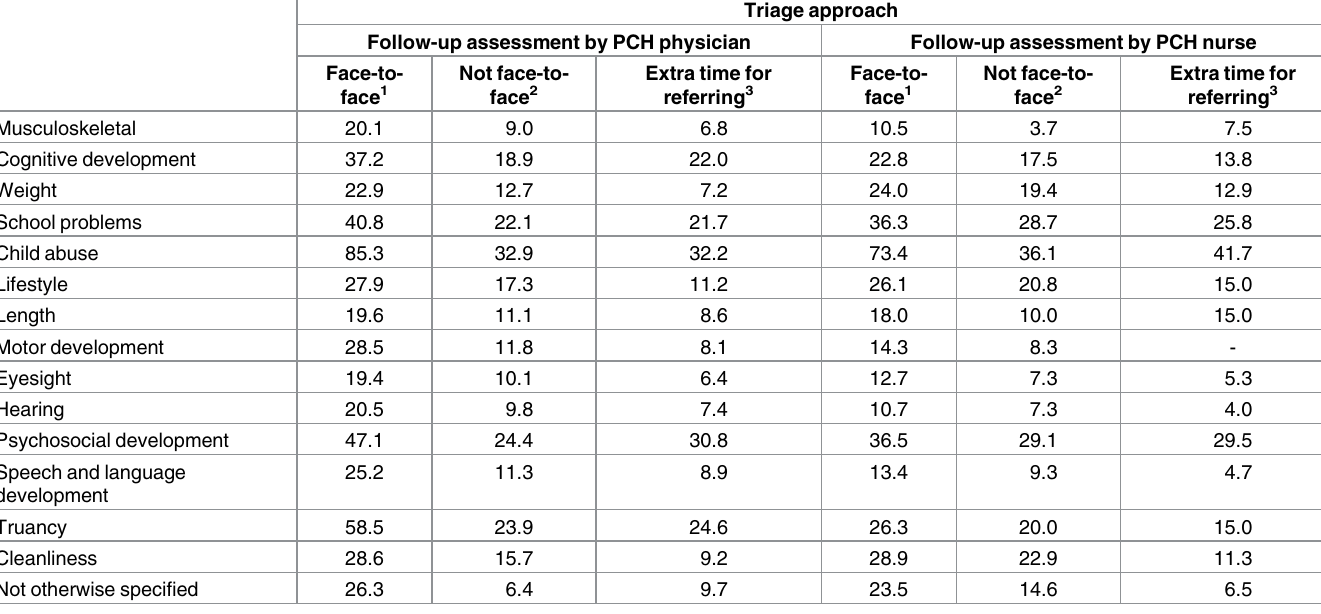
Table 3. Averageestimated time spent by professionals on follow-up assessments in the triage approach